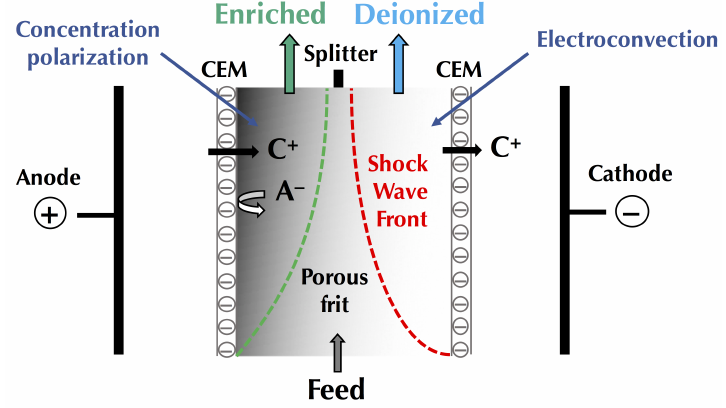
Figure 21. Principle of shock ED. CEM: cation-exchange membrane; A − : anions; C + :